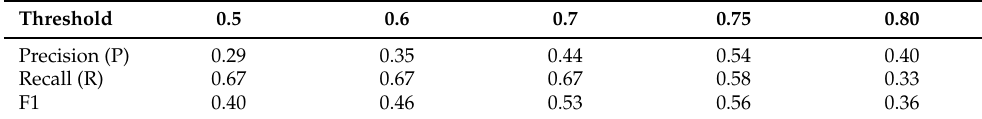
Table 14. AEDs Drug-Drug Similarity Evaluation